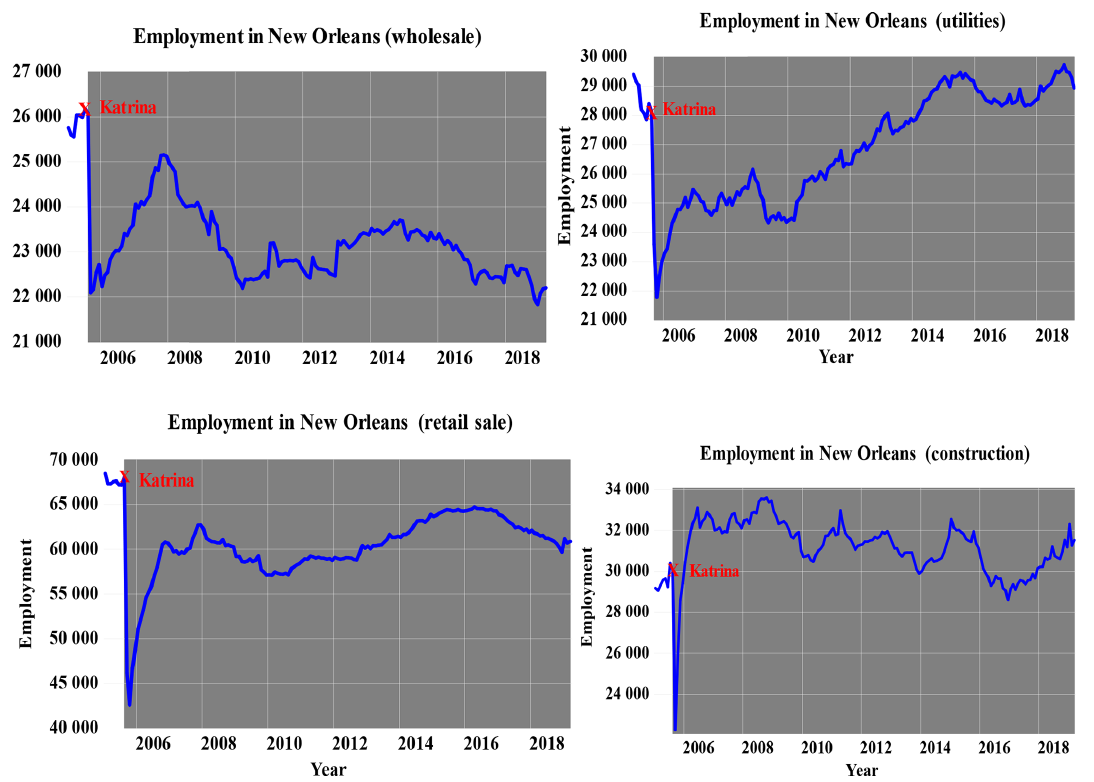
Figure 7. Monthly employment in four industries for New Orleans